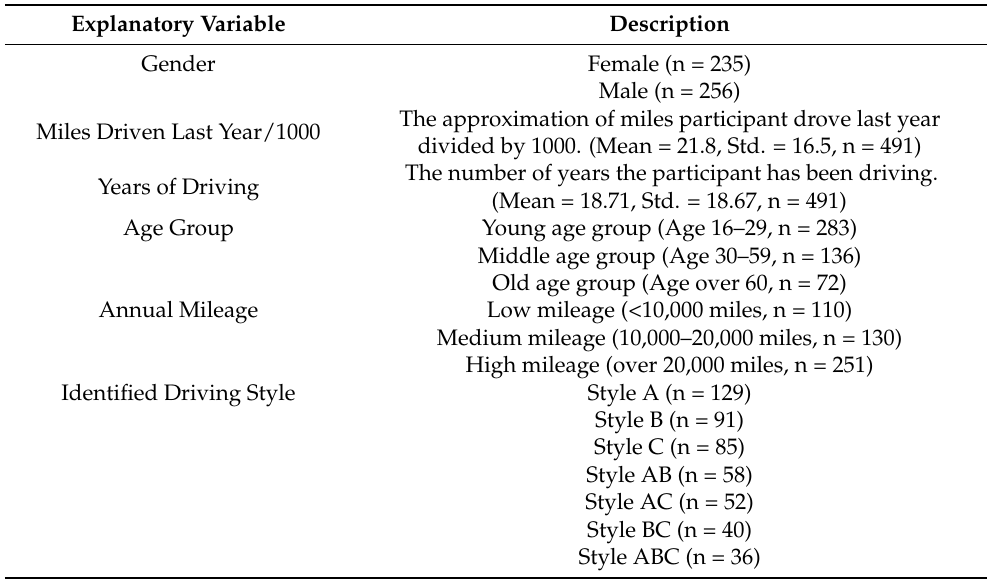
Table 4. Independent variables used for the crash risk analysis at driver level.